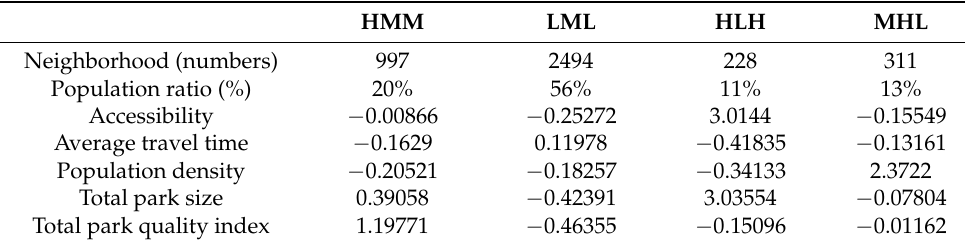
Table 4. Final cluster